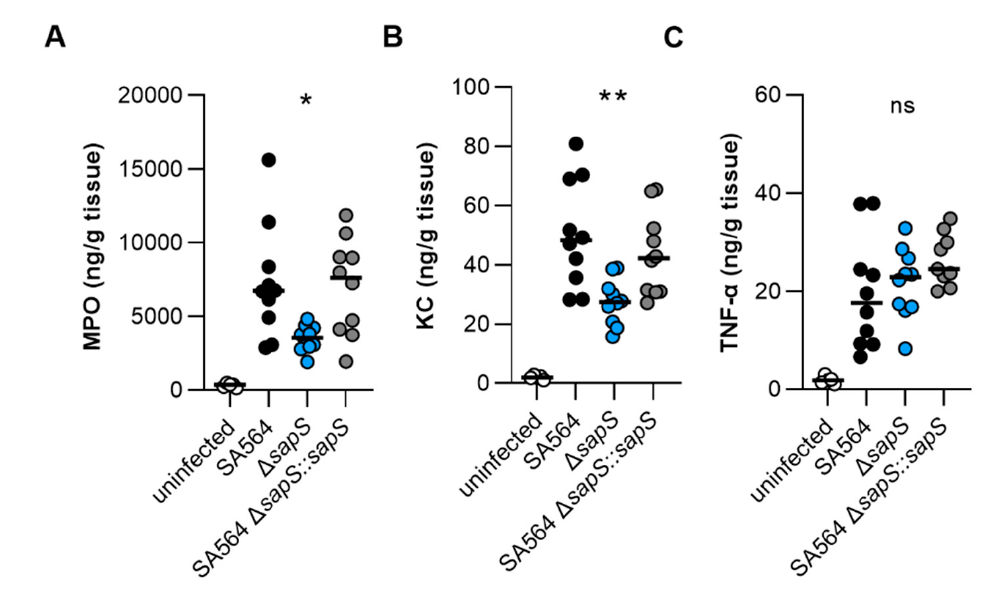
Figure 6. MPO, KC, and TNF- α contents in kidney tissues obtained from mice at day 4 post infection. C57BL/6N mice were infected with S. aureus strain SA564 (black symbols), SA564 ∆ sapS (blue symbols), and the cis -complemented derivative SA564 ∆ sapS::sapS (grey symbols), respectively (n = 10 per group). Four days after infection, mice were euthanised, kidneys were extracted and blended with PBS solution, the tissue homogenates centrifuged, and the MPO ( A ), KC ( B ), and TNF- α ( C ) contents in the supernatants determined by enzyme-linked immunosorbent assays. Kidney homogenates from age-matched uninfected mice served as control (white symbols). Each symbol represents the amount of enzyme/cytokine found in the kidney homogenate of an individual mouse. The median of all the observations is shown by the horizontal bar. ns, not significant; * p < 0.05; **, p < 0.01 (Kruskal–Wallis test followed by Dunn’s post hoc test. Only significant differences between WT-infected and mutant-infected mice are